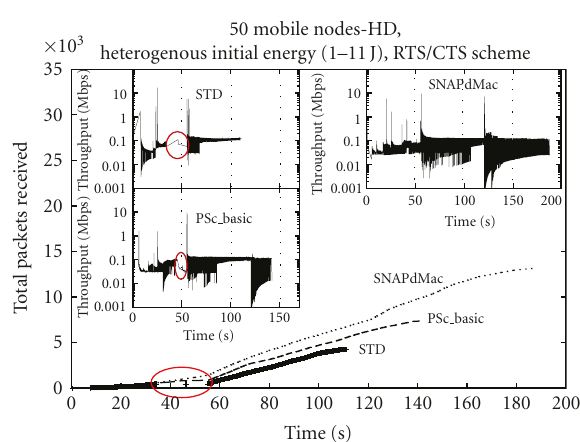
Figure 13: Total number of packets received and throughput— heterogeneous network, RTS/CTS exchange scheme.